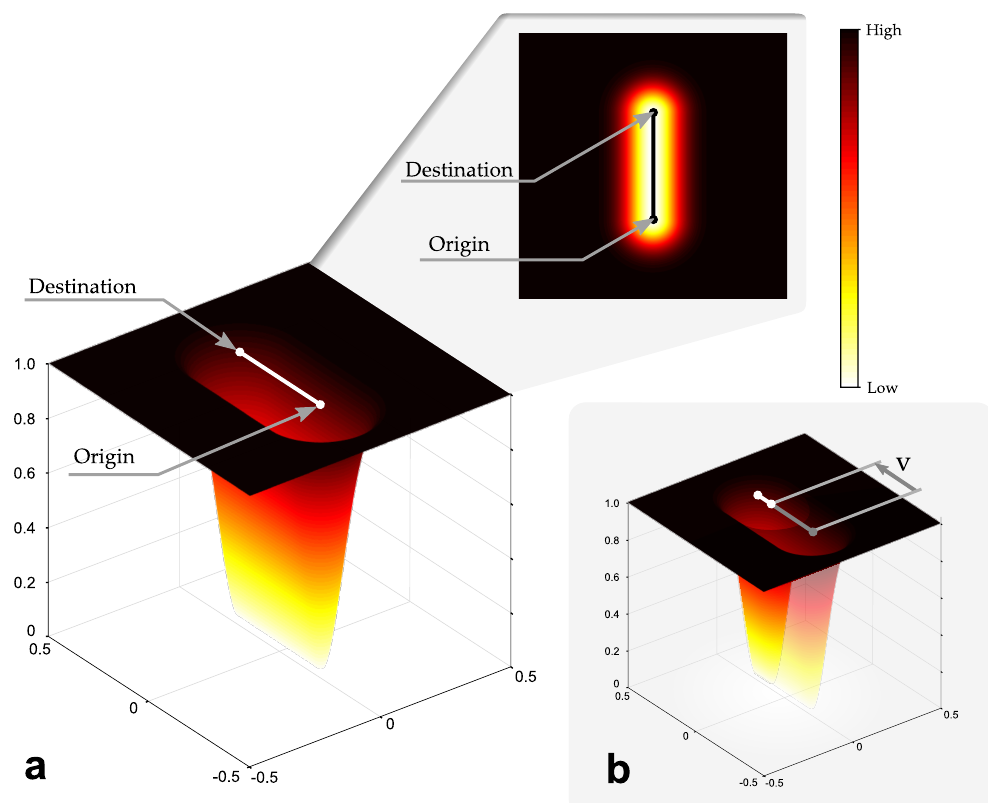
Figure 2. Graphic representation of the force fields used in this study. ( a ) Force fields in the form of a tunnel with ends. ( b ) Version of the force field in the form of a tunnel where the origin moves at constant velocity in order to help the patient to move towards the target. The scale represents the normalized assistance force magnitude applied in each position. The maximum assistance force value is configured by means of the assistance level of the robotic rehabilitation